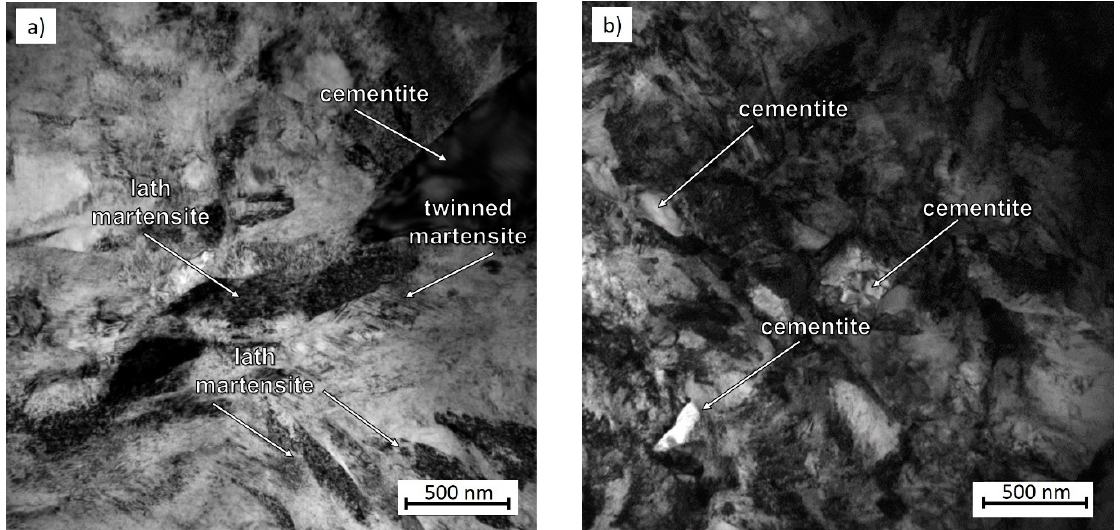
Figure 9. Regime 1: 1200 °C/water: general micrographs, ( a ) lath martensite and twinned martensite, part of an Fe 3 C cementite particle is visible at the edge of the micrograph; ( b ) smaller cementite particles in the martensitic matrix.